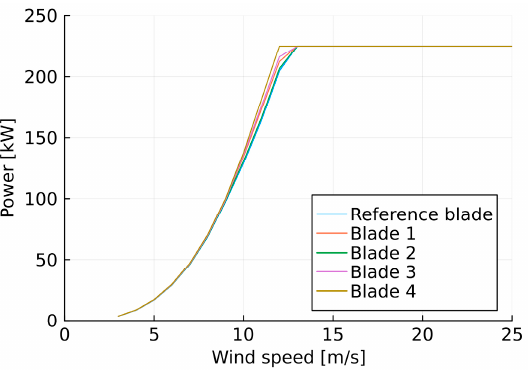
Figure 5. Power curve comparisons of the V27 wind turbine with the optimised blades.